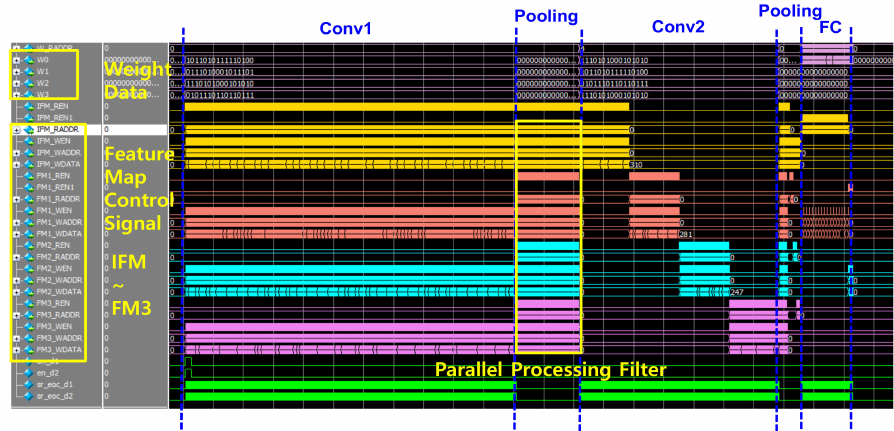
Figure 13. The simulation result of top CNN to analysis feature